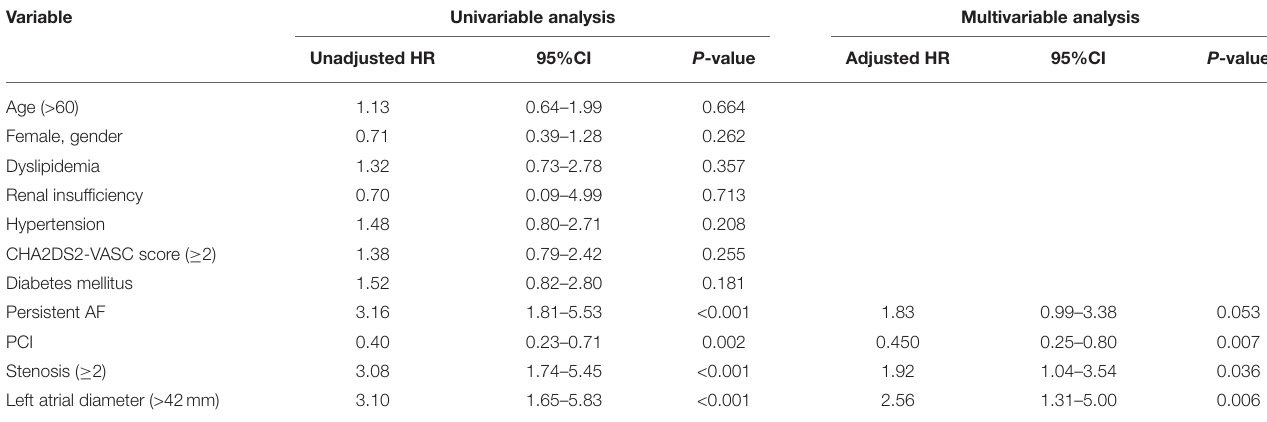
TABLE 3 | Univariable and multivariable regression analyses of the recurrence of atrial fibrillation in the patients with obstructive CAD. Variable